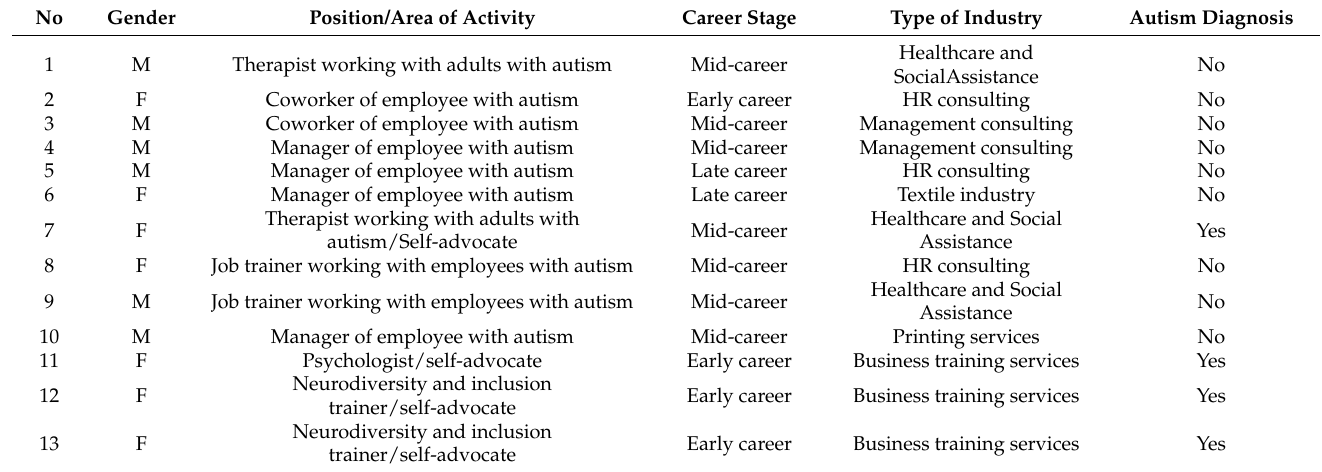
Table 1. Detailed information on the research